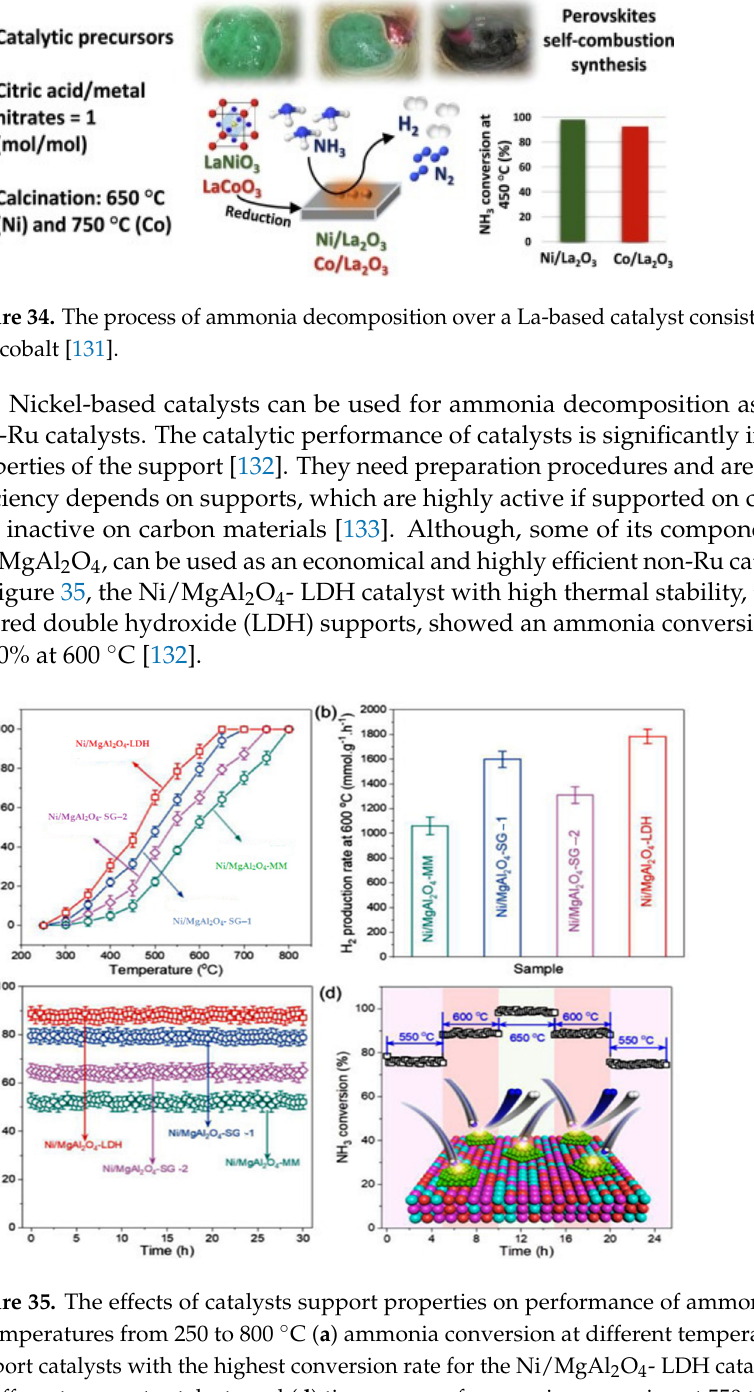
Figure 35. The effects of catalysts support properties on performance of ammonia decomposition at temperatures from 250 to 800 °C ( a ) ammonia conversion at different temperatures ( b ) different support catalysts with the highest conversion rate for the Ni/MgAl 2 O 4 - LDH catalyst ( c ) time course of different support catalysts and ( d ) time course of ammonia conversion at 550 to 600 °C [132]. Figure 36. Ammonia cracking over Ni-based catalysts at different temperatures from 350 to 650 °C. the highest ammonia conversion rate at different temperatures reached with Ni/Y 2 O 3 . Reprinted with permission [111].